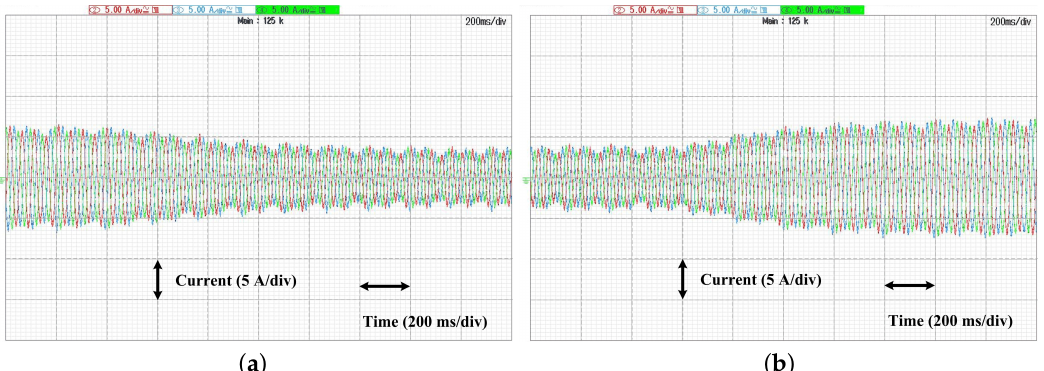
Figure 19. Actual three-phase currents when the motor load is decreasing and increasing; time scale: 200 ms/div. ( a ) from 5 N · m to 3 N · m; and ( b ) from 3 N · m to 5 N ·